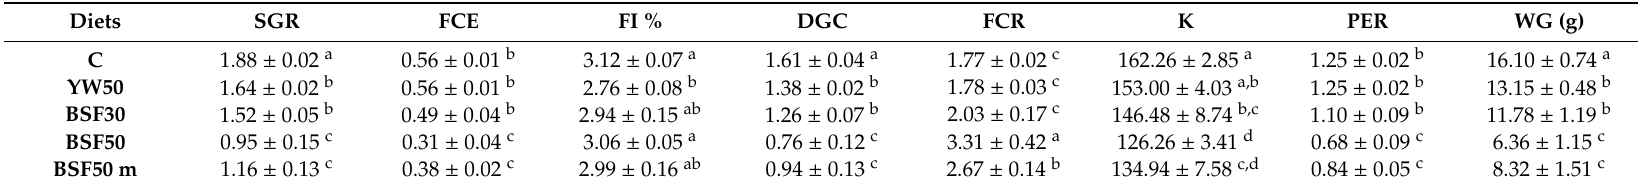
Table 1. Fish performance indices ( n = 3 mean ± SD) of D. labrax fed the five experimental